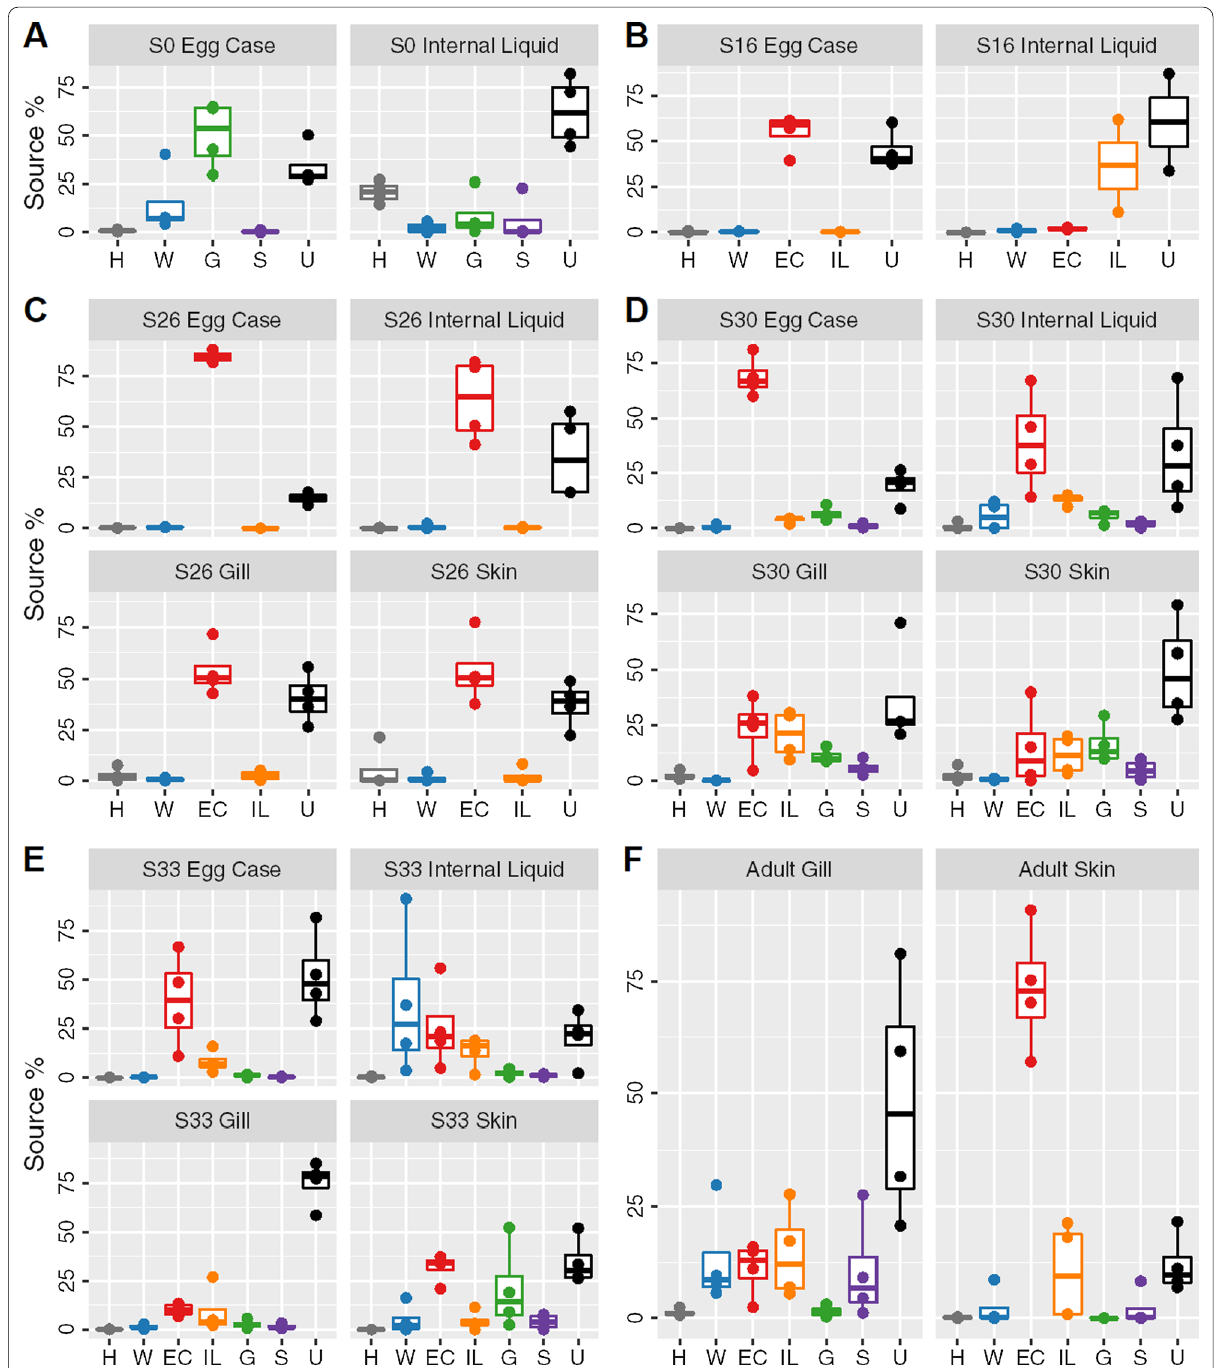
Fig. 4 Source contributions to the little skate microbiota for each stage and tissue. Boxplots showing source contributions to the bacterial community of the skate microbiota at stage 0 ( A ), stage 16 ( B ), stage 26 ( C ), stage 30 ( D ), stage 33 ( E ) and adult ( F ) estimated using FEAST. Stage 0 used adult tissues as the source pools. Source contributions to adults ( F ) are shown for stage 33 source pools. Sources are colored as in Fig. 2. Letter codes refer to source pools from the previous stage or controls. H: Experimenters’ hands, W: water; EC: egg capsule, IL: egg capsule internal liquid, G: gill, S: skin, U: unknown